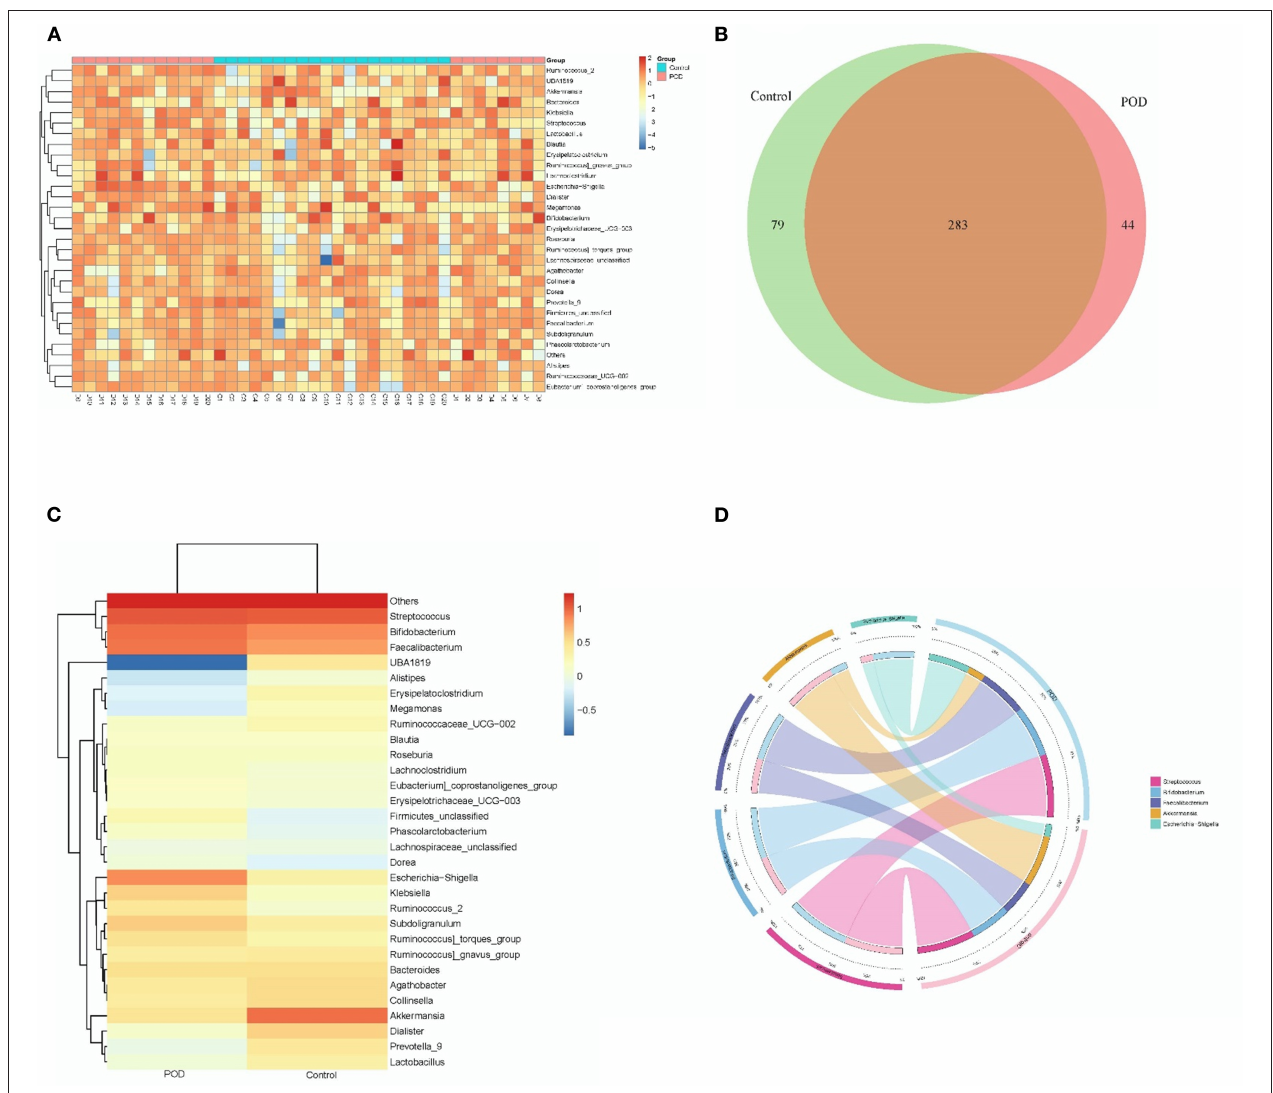
FIGURE 1 | Bacterial composition analysis in different samples (A) and cohorts (B) . Venn plot depicting common and specific microbes in different cohorts (C) . Circos plot showing the corresponding relation between cohorts and bacterial species81 (D)